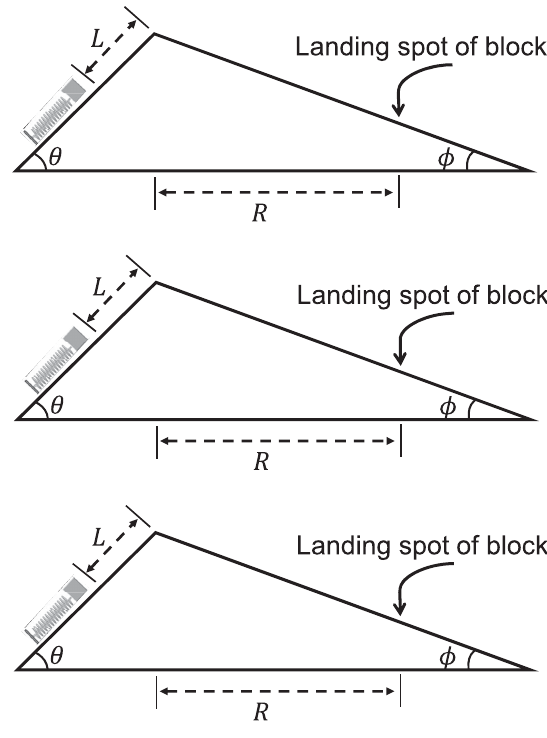
FIG. 2. The three versions of the sequential synthesis